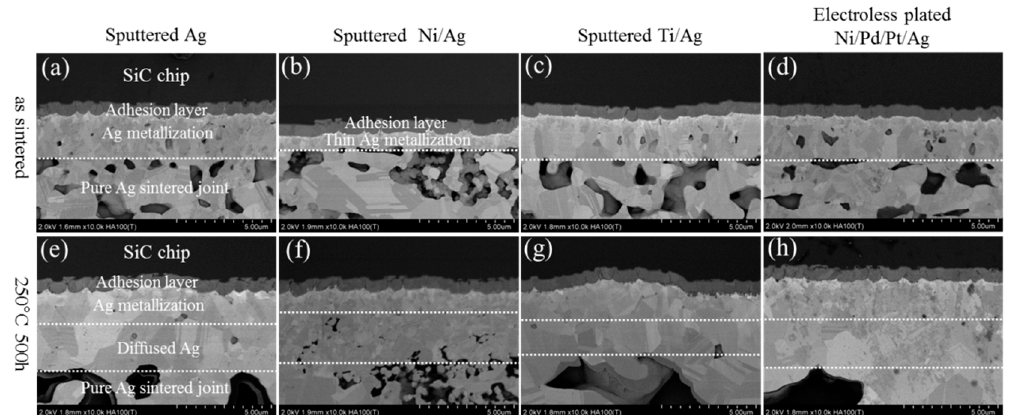
Figure 3. Evolution of pure Ag sintered joint at the chip sides in as-sintered state and after high temperature storage (HTS) for 500 h: ( a – d ) as sintered state, ( e – h ) after HST for 500 h.